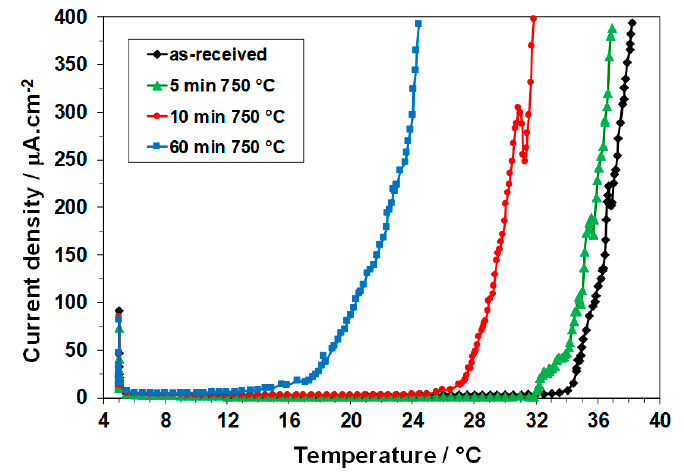
Figure 4. Current density vs. temperature curves obtained in 0.1 M NaCl solution on both as-received and aged DSS 2304.